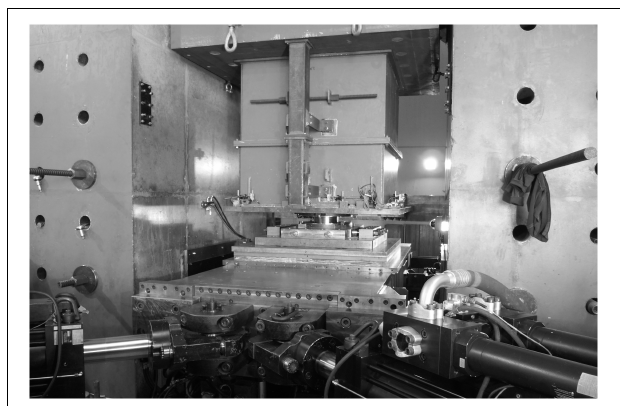
FIGURE 3 | Testing setup of the Bearing Tester System at the EUCENTRE